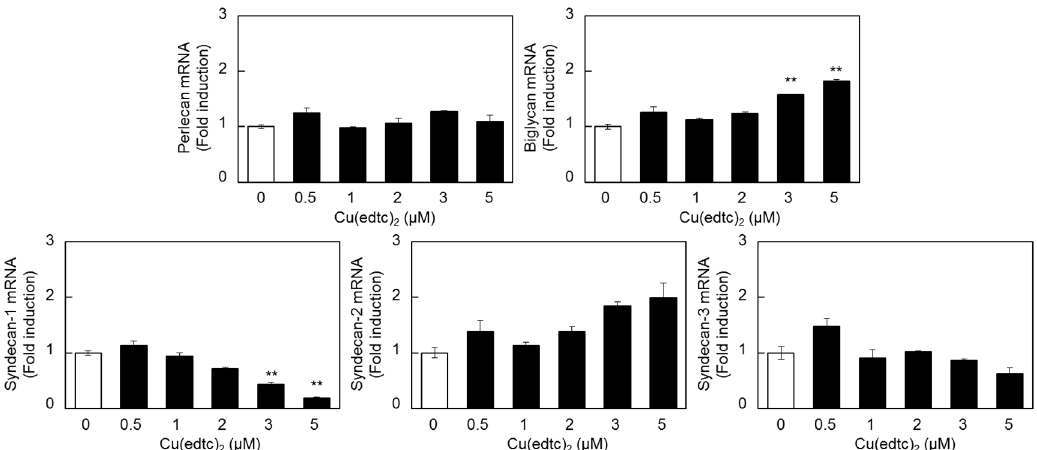
Figure 2. Effects of Cu(edtc) 2 on the expression of perlecan , biglycan , syndecan-1 , syndecan-2 , and syndecan-3 mRNA in vascular endothelial cells. The cells were incubated at 37 °C for 8 h in the presence of Cu(edtc) 2 (0.5, 1, 2, 3, and 5 µM). Proteoglycan mRNA levels were then determined by RT-PCR. Values are means ± S.E. of four replicates. ** p < 0.01 vs. control.